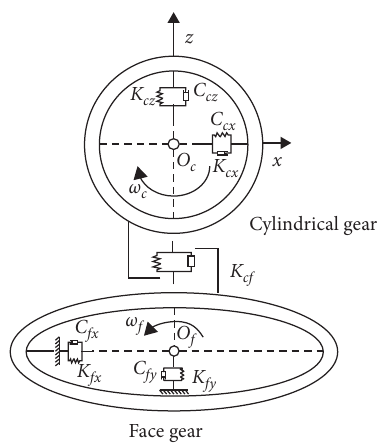
Figure 6: Simplified model of face gear contact